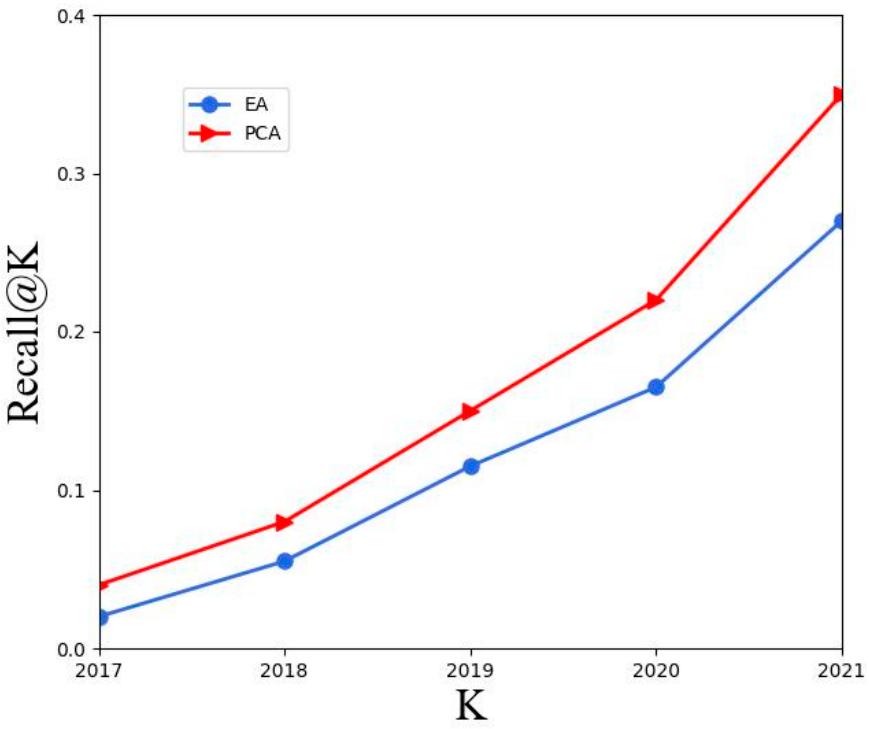
Figure 3. Experimental results of Recall@K on analysis popularity of tourism product model.